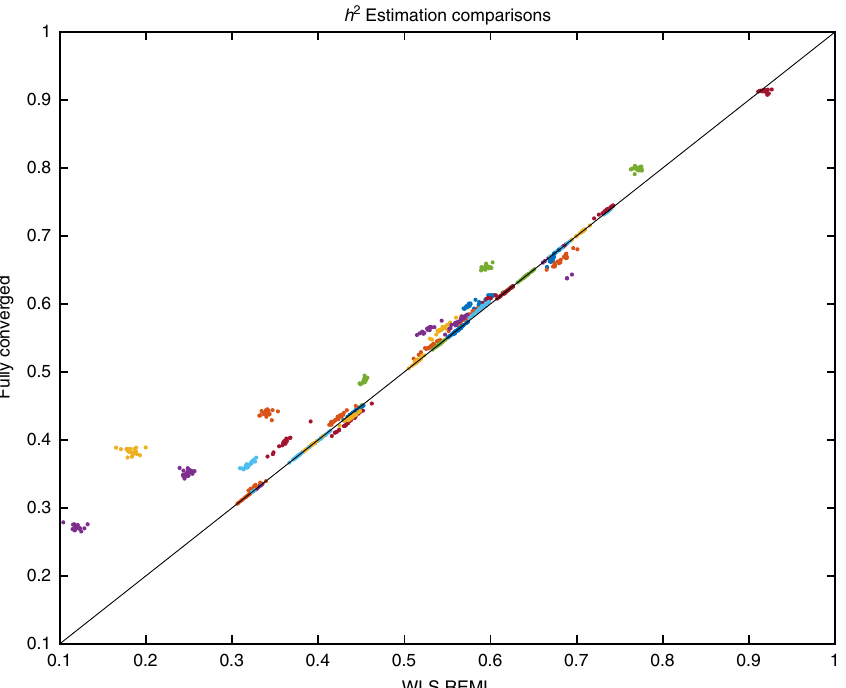
based on the simpli fi ed REML function using real data analysis. Colors Fig. 5 Comparison of one-step and fully converged random effect estimators of σ 2 A represent random effect estimation at different regions for all 22 chromosomes. The scatter plot show consistent trend towards underestimation of random effect using non-iterative method, though this apparent increased accuracy comes with a 10 9 -fold greater computation